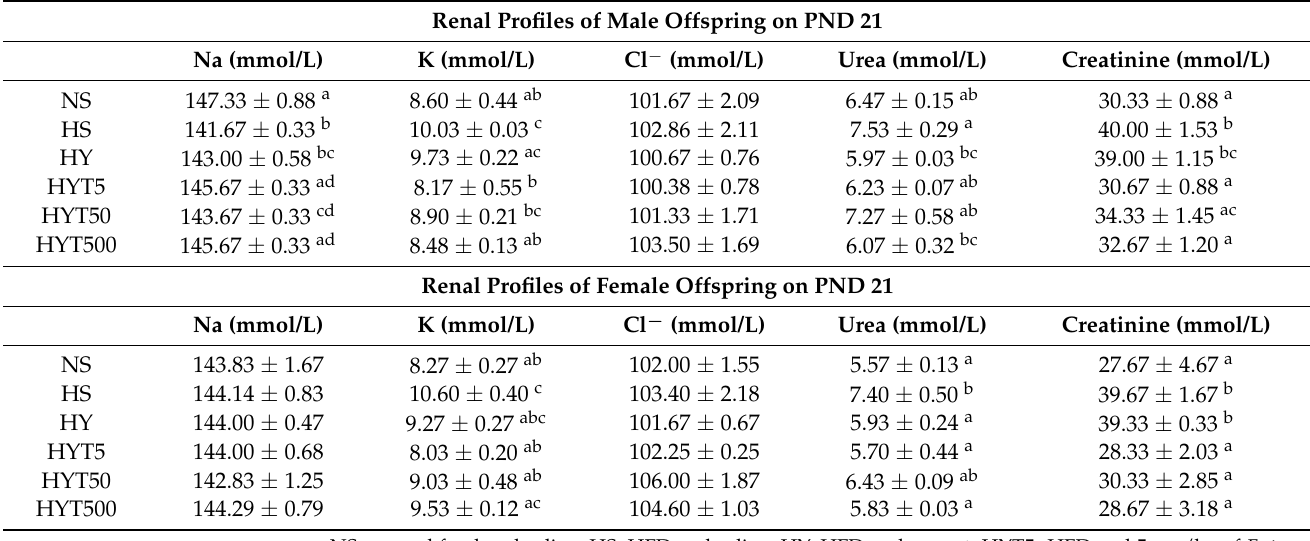
Table 3. Renal profiles of male and female offspring on PND 21. Renal Profiles of Male Offspring on PND